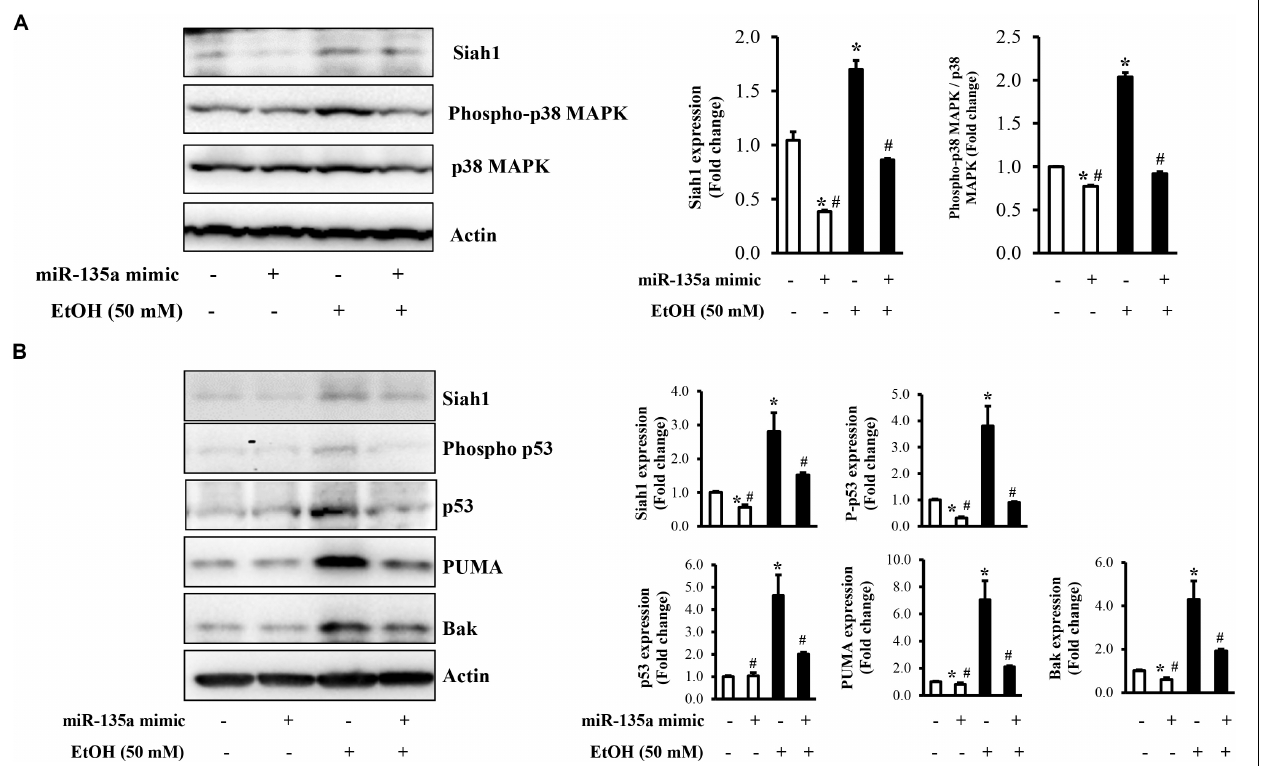
FIGURE 4 | Overexpression of miR-135a reduced the ethanol-induced activation of the p38 mitogen-activated protein kinase (MAPK)/p53 pathway in neural crest cells (NCCs). NCCs transfected with control mimics or miR-135a mimics were treated with 50 mM ethanol for 24 h. The expression of Siah1, total p38, and phosphorylated p38 (A) , and the expression of Siah1, phosphorylated p53, p53, p53 upregulated modulator of apoptosis (PUMA), and Bcl-2 homologous antagonist/killer (Bak; B ) were determined by western blot. Data are expressed as fold change over control and represent the mean ± SD of three separate experiments. * p < 0.05 vs. control; # p < 0.05 vs.